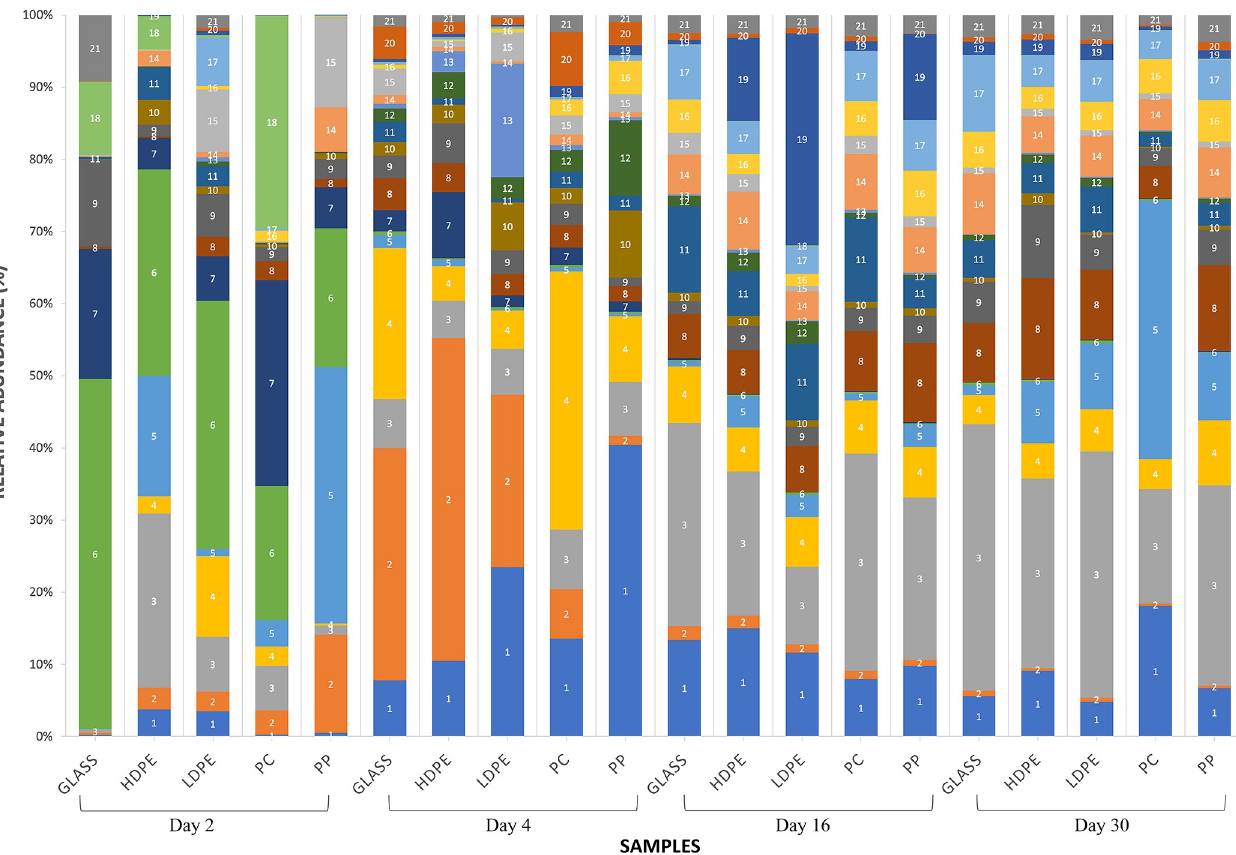
Fig 7. Relative abundances of sequenced Bacteria in Colonization Experiment #1. Substrate types: low-density polyethylene (LDPE), high-density polyethylene (HDPE), polypropylene (PP), polycarbonate (PC), and glass (G). Paired water samples were not collected. The most abundant OTUs are listed as follows: (1) Bacteria, Bacteria Unclassified; (2) Bacteria, Proteobacteria, Gammaproteobacteria, Pseudomonadales, Pseudomonadaceae, Pseudomonas; (3) Bacteria, Proteobacteria, Gammaproteobacteria, Oceanospirillales, Oceanospirillaceae; (4) Bacteria, Bacteroidetes, Flavobacteria, Flavobacteriales, Flavobacteriaceae, Tenacibaculum; (5) Bacteria, Proteobacteria, Gammaproteobacteria, Pseudomonadales, Pseudomonadaceae, Pseudomonas; (6) Bacteria, Bacteroidetes, Flavobacteria, Flavobacteriales, Flavobacteriaceae, Maribacter; (7) Bacteria, Verrucomicrobia, Verrucomicrobiae, Verrucomicrobiales, Rubritaleaceae, Rubritalea; (8) Bacteria, Bacteroidetes, Flavobacteria, Flavobacteriales, Flavobacteriaceae, Flavobacterium; (9) Bacteria, Proteobacteria, Gammaproteobacteria, Alteromonadales, Pseudoalteromonadaceae, Pseudoalteromonas; (10) Bacteria, Proteobacteria, Gammaproteobacteria, Oceanospirillales, Oceanospirillaceae, Oleibacter; (11) Bacteria, Actinobacteria, Actinobacteria, Actinomycetales, Corynebacteriaceae, Corynebacterium; (12) Bacteria, Proteobacteria, Alphaproteobacteria, Rhodobacterales, Rhodobacteraceae; (13) Bacteria, Bacteroidetes, Flavobacteria, Flavobacteriales, Flavobacteriaceae; (14) Bacteria, Proteobacteria, Gammaproteobacteria, Alteromonadales, Alteromonadaceae, Glaciecola; (15) Bacteria, Bacteria Unclassified; (16) Bacteria, Proteobacteria, Gammaproteobacteria, Vibrionales, Vibrionaceae, Vibrio; (17) Bacteria, Proteobacteria,